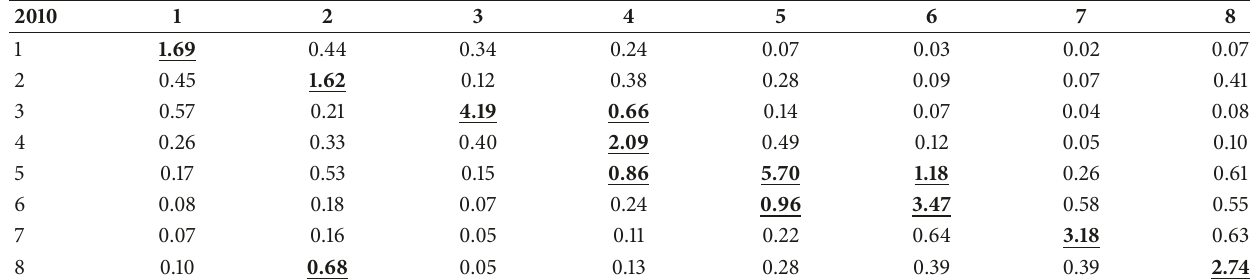
Table 7: Subgroup density table of the HRB urban network in 2010.